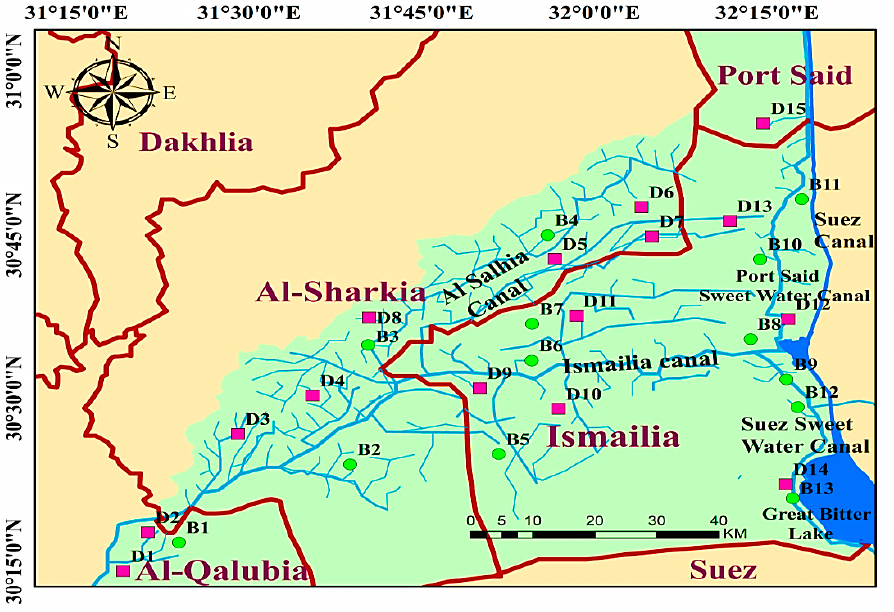
Figure 4. Ismailia canal and demand nodes in the study area.